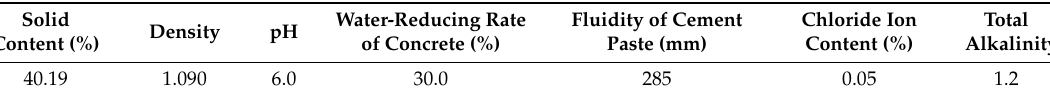
Table 4. Parameters of the water-reducing agents.